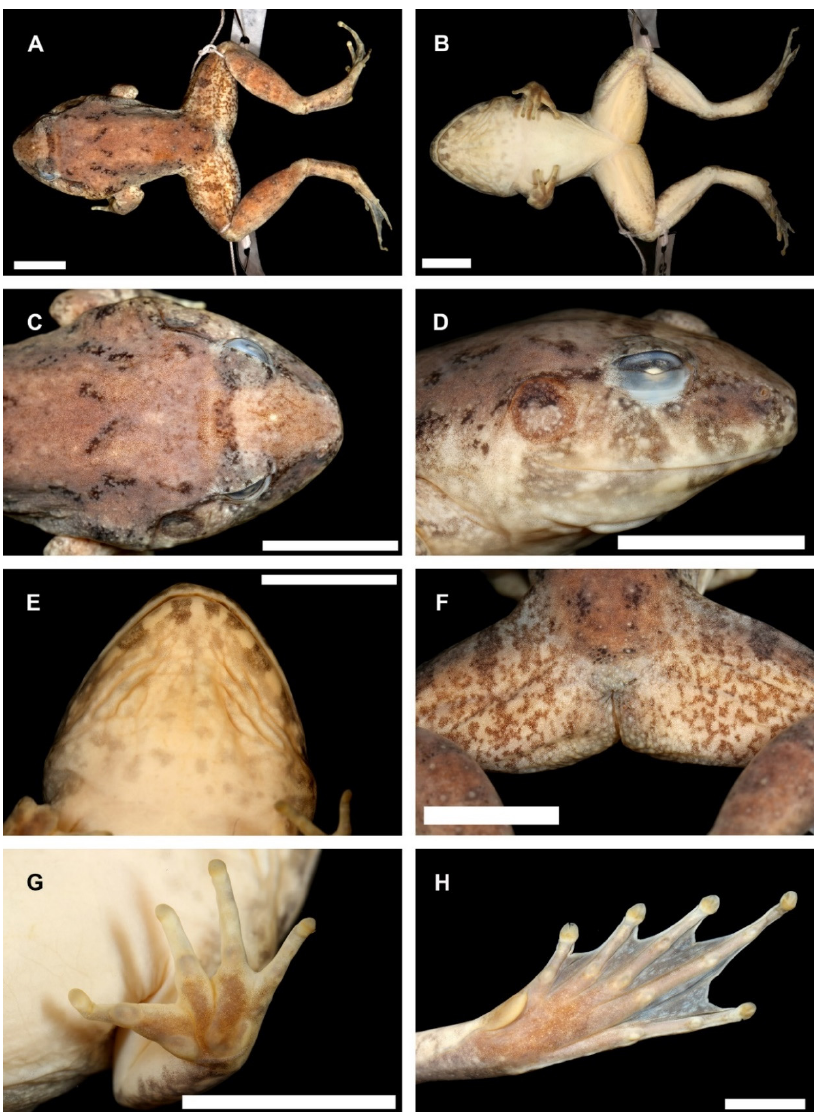
Figure 9. Holotype of Limnonectes bagoensis n. sp. (SMF 104090). (A). dorsal view; (B). ventral view; (C). dorsal view of head; (D). lateral view of head; (E). ventral view of head; (F). cloacal and thigh region; (G). palmar surface of hand; (H). plantar surface of foot. Scale bars equal 5.0 mm. Photos by G.K.